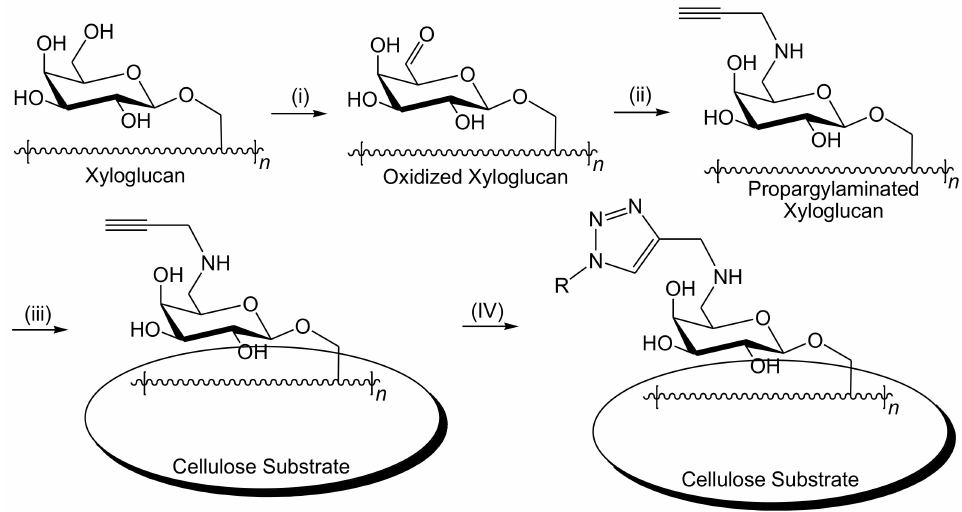
Figure 6. Chemo-enzymatic development of the cellulose-based esterase biosensor via the activation of cellulose surface using galactosylated hetero-polysaccharides; ( i ) galactose oxidase-mediated oxidation using O 2 , galactose oxidase, catalase, and peroxidase at room temperature in H 2 O; ( ii ) reductive amination by propargylamine, NaCNBH 3 , and CH 3 COOH at room temperature in H 2 O or H 2 O / CH 3 OH (2:1); ( iii ) physical adsorption onto cellulose substrate at room temperature in aqueous medium; ( iv ) in situ Cu(I)-catalyzed click reaction by applying 6-carboxyfluorescein tetraethylene glycol azide (RN 3 ), CuSO 4 , sodium ascorbate, and tris-hydroxypropyl triazolylamine in a mixture of H 2 O / butanol